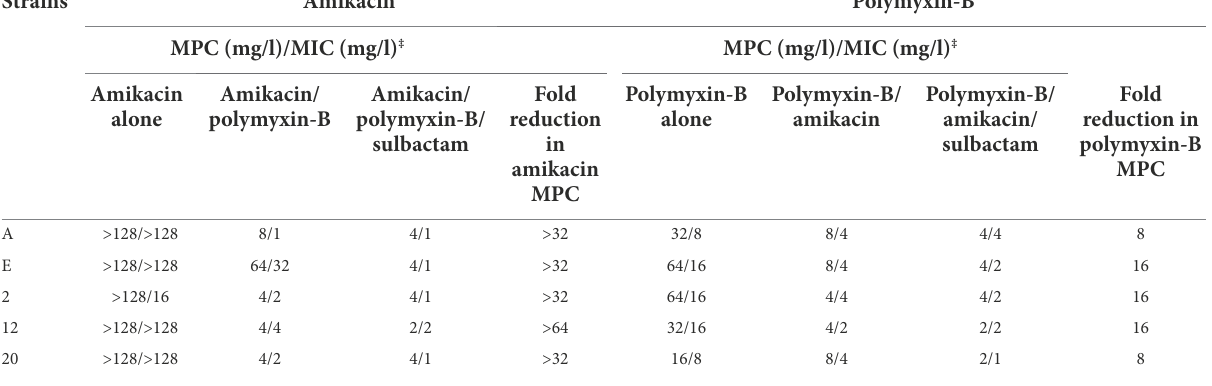
TABLE 3 Mutant prevention concentrations of amikacin and polymyxin B alone or in combination with or without sulbactam (fixed at 4 mg/l) against five Acinetobacter baumannii isolates harboring OXA-23 and other serine- β -lactamases. Strains